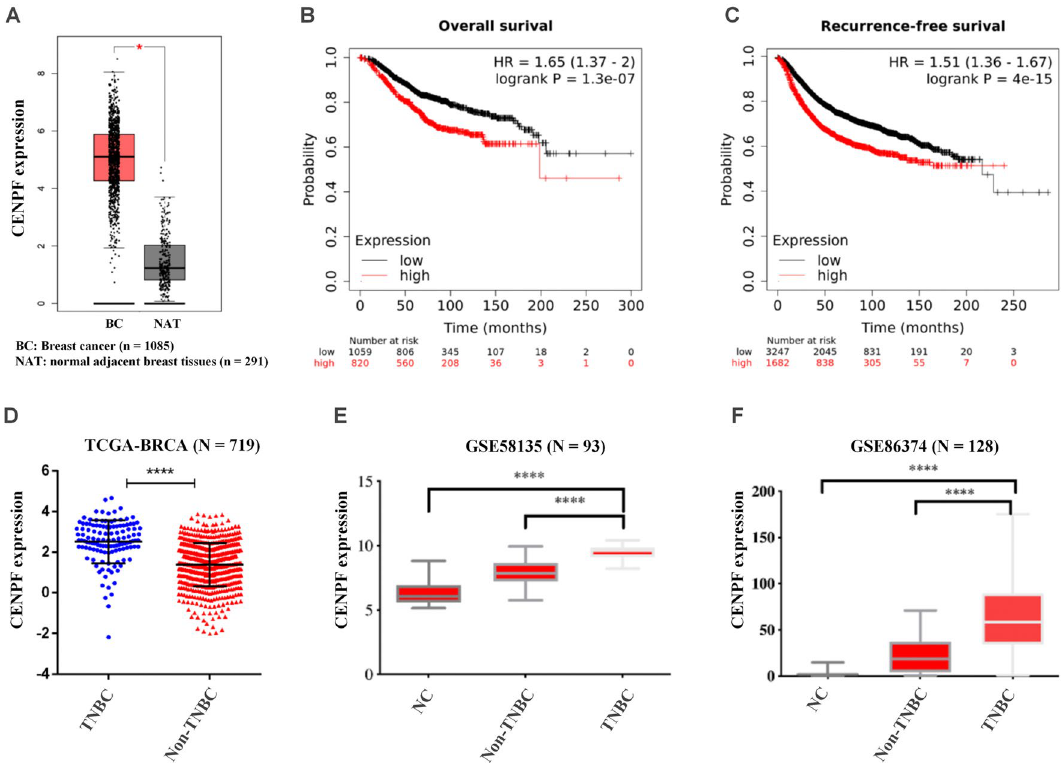
Figure 1. CENPF is highly expressed in triple-negative breast cancer. ( A ) CENPF expression in breast cancer tissues (n = 1,085) and adjacent peritumoral tissues (n = 291) from the TCGA and GTEx databases using GEPIA (http:// gepia. cancer- pku. cn/ index. html). ( B , C ) Overall survival ( B , n = 1 879, log-rank P = 1.3e−07) and recurrence-free survival ( C , n = 4929, log-rank P < 1e−15) of breast cancer patients. Data were obtained from Kaplan ‒ Meier Plotter (http:// kmplot. com/ analy sis/). ( D – F ) Based on data from the TCGA ( D ), GSE58135 ( E ) and GSE86374 ( F ), CENPF expression in TNBC and non-TNBC samples. Data shown represent the means (± standard deviation [SD]); *P < 0.05, ****P < 0.0001; log-rank test ( B , C ), Student’s t test ( D ) or one-way ANOVA ( E , F